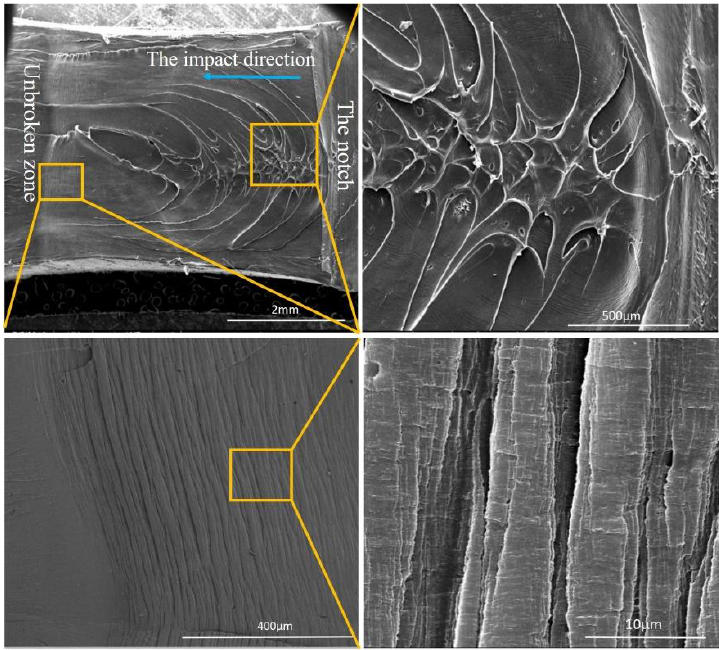
Figure 10. SEM images of impacted surface ofA8K2 blend.